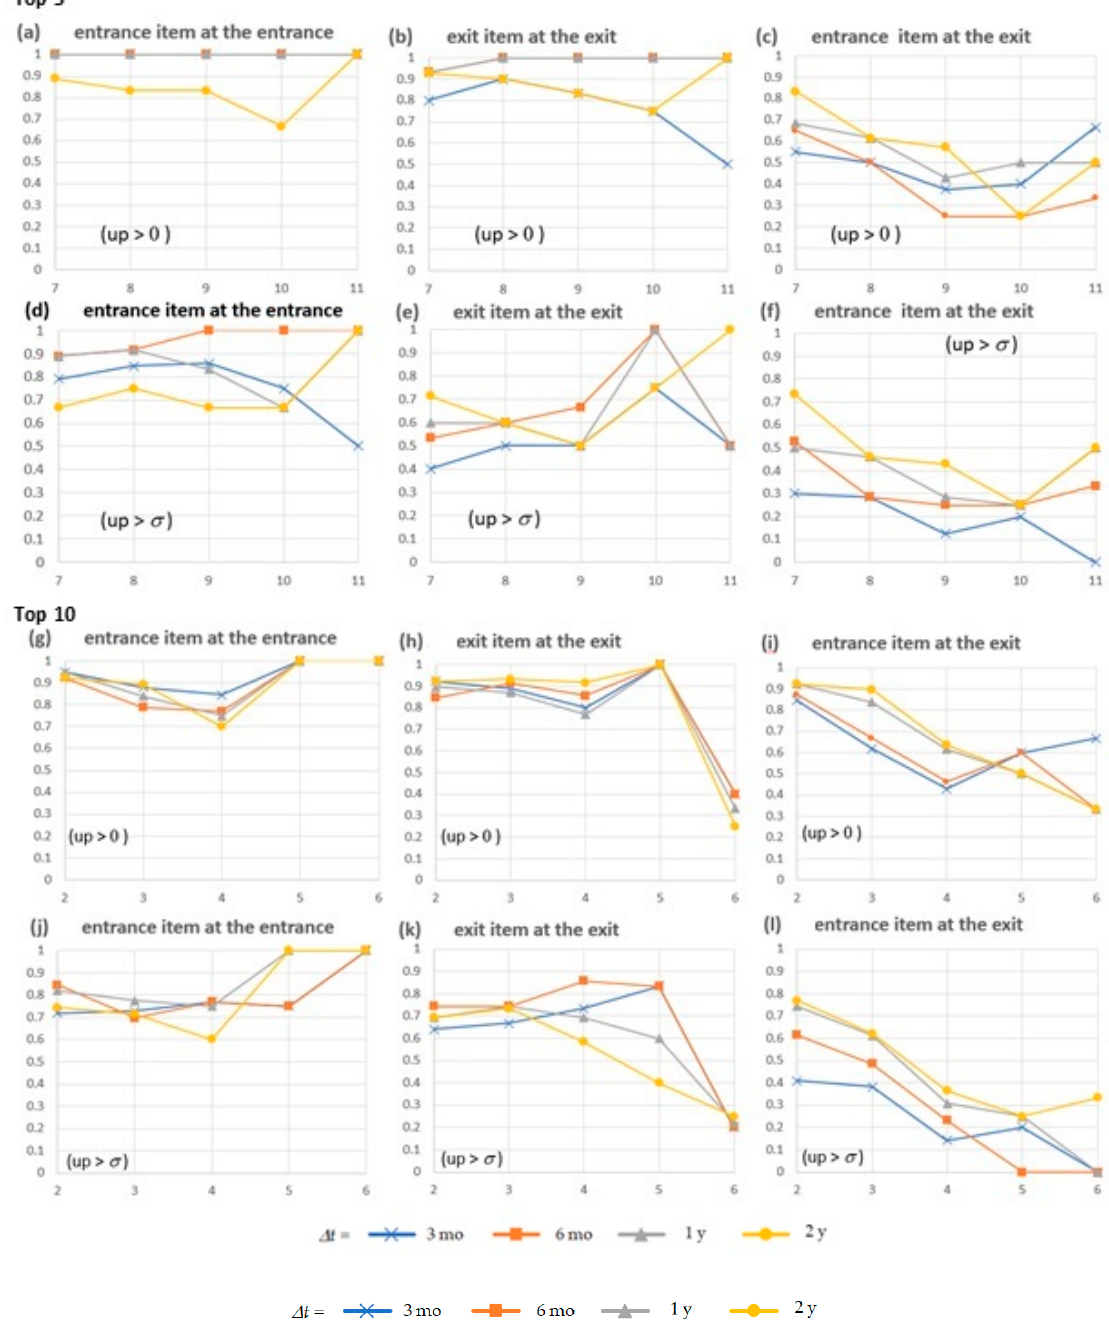
Figure 9. Price rates (vertical) for entrance/exit items at the entrance/exits. The horizontal axes show the values of W . See Figure 8 and the main text for the meaning of panel ( a )–( l ), and the Supplementary data S2 for the real values. For example, ( c ), ( f ), ( i ), and ( l ) show the price-up rates (i.e., increase rate in price) of the stock item that appeared at the entrance of a pill, evaluated at the exit of the same pill, corresponding to Figure 8c, respectively.